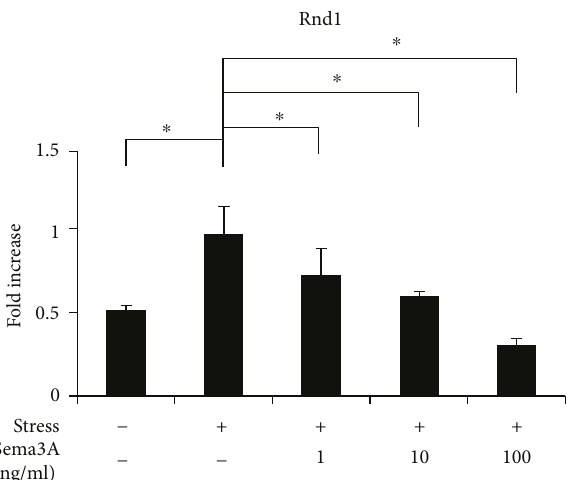
Figure 6: E ff ect of Sema3A on gene expression of Rnd1 under excessive mechanical stress. ATDC5 cells treated with various concentrations of Sema3A were subjected to excessive CTS for 3 h. Gene expression of Rnd1 was determined by qPCR analysis. Data are expressed as mean ± SD, n = 3 . ∗ P < 0 05 compared to the group with CTS but without Sema3A.